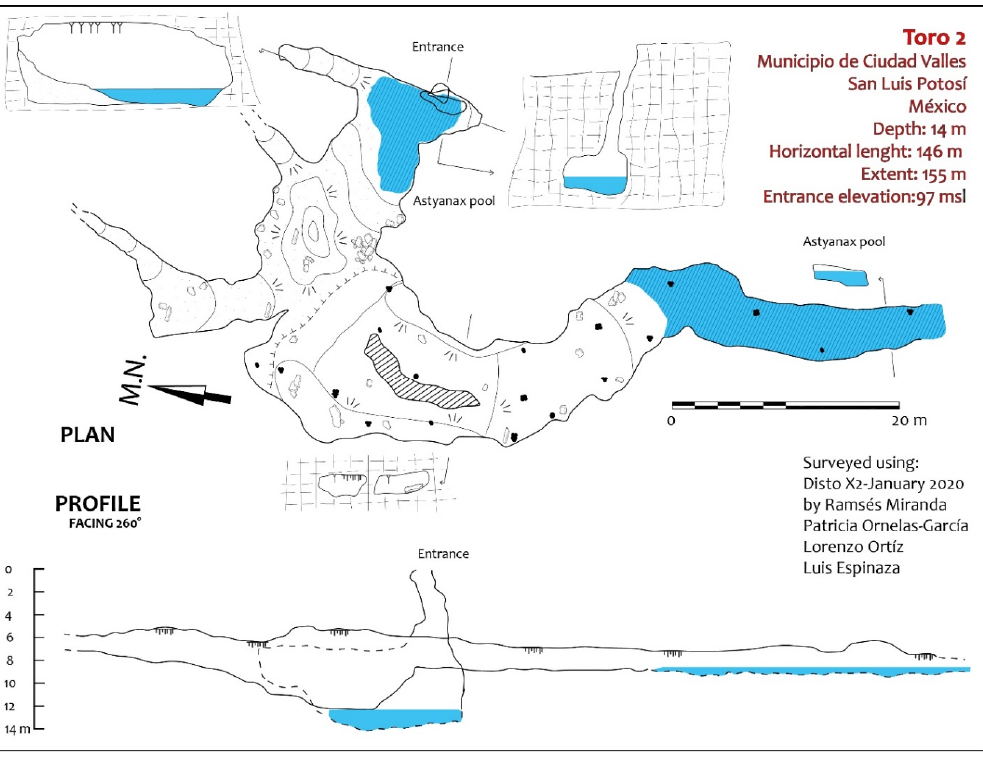
Figure 5. Map of Sótano del Toro # 2. Figure 5. Map of S ó tano del Toro # 2.